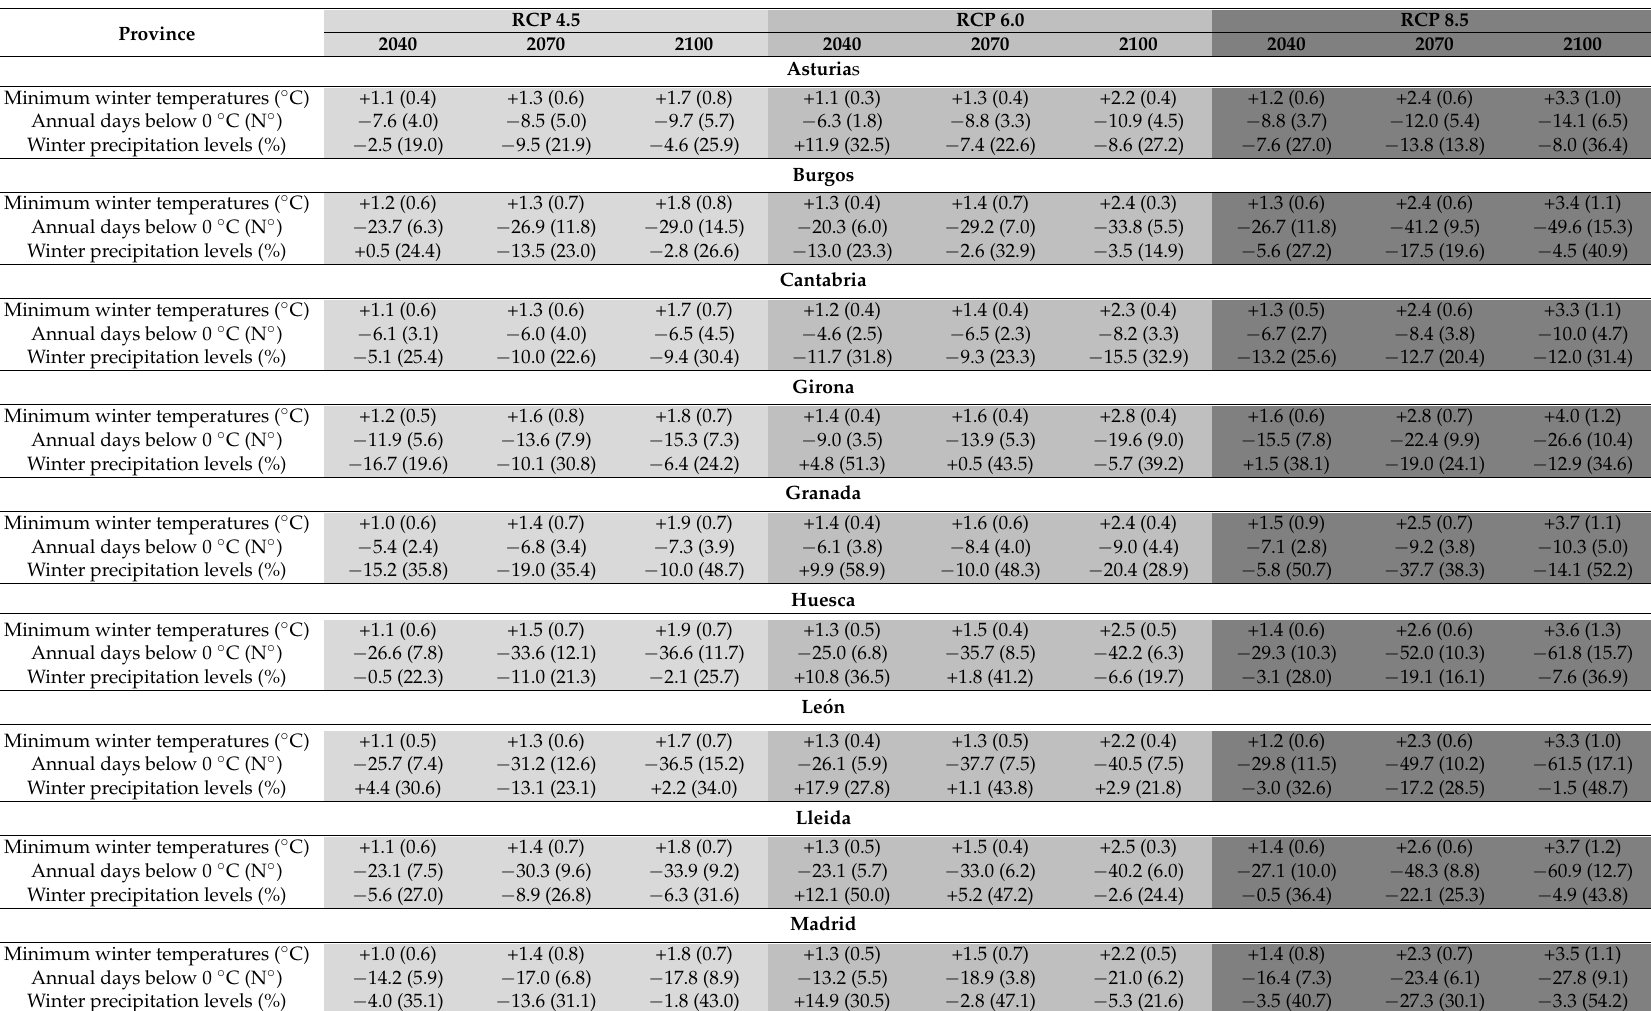
Table A2. Projected climate changes for the provinces of the ski